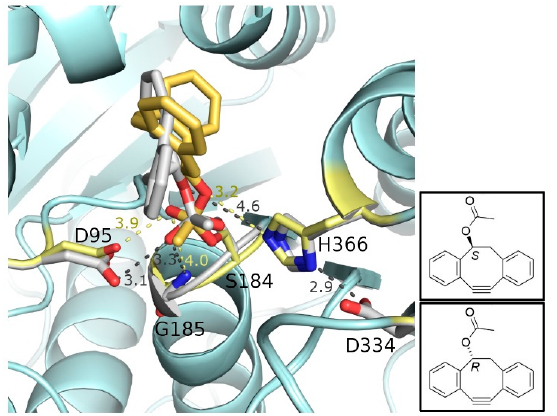
Figure 1. ( R )- and ( S )- 2 (R 1 = Me) docked to the active site of CAL-A. ( S )- 2 (R 1 = Me) (yellow) likely binds to the active site of CAL-A by forming a tight interaction network of hydrogen bonds to the oxyanion hole and the catalytic residues. However, if the carbonyl oxygen of ( R )- 2 (R 1 = Me) (grey) is within hydrogen bonding distance to the oxyanion hole, the catalytic H366 is too far away from the other oxygen (4.6 Å) to be able to abstract the proton and form the reaction intermediate D (Scheme 2). Consequently, it is unlikely that CAL-A can form a productive reaction complex with ( R )- 2 (R 1 = Me). 2D structures of ( S )- and ( R )- 2 (R 1 = Me) are shown to the